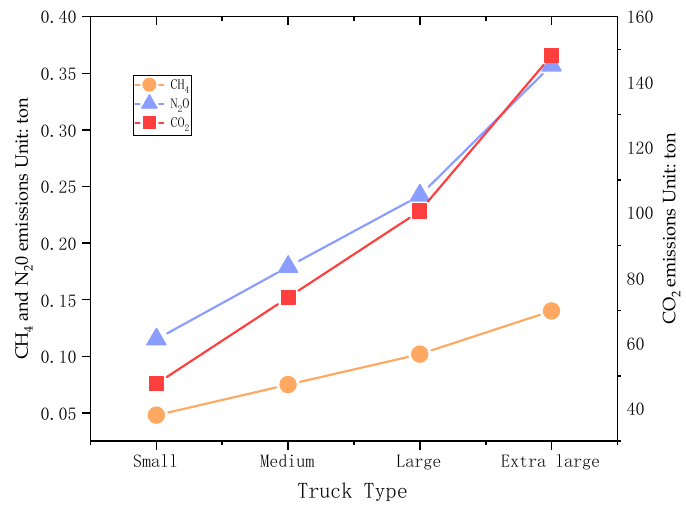
Figure 13. Lower carbon emissions benefits.